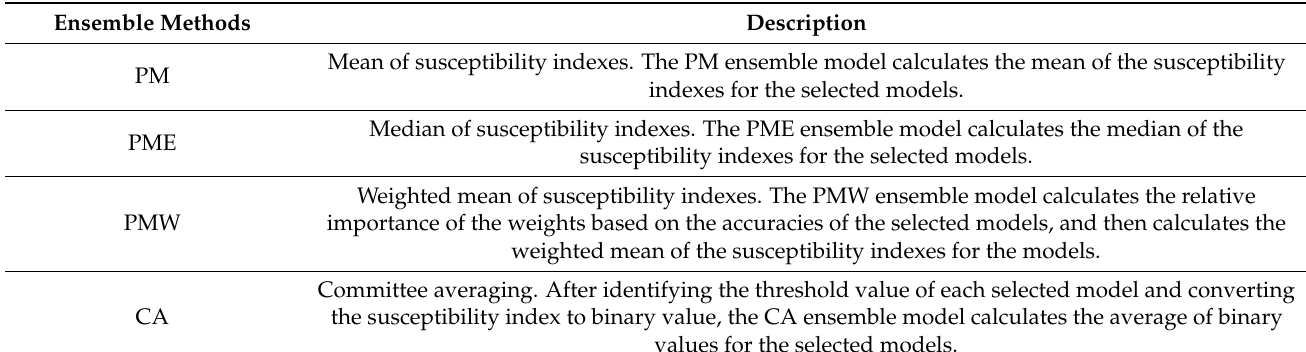
Table 1. The ensemble methods to aggregate the results of the selected models. Ensemble